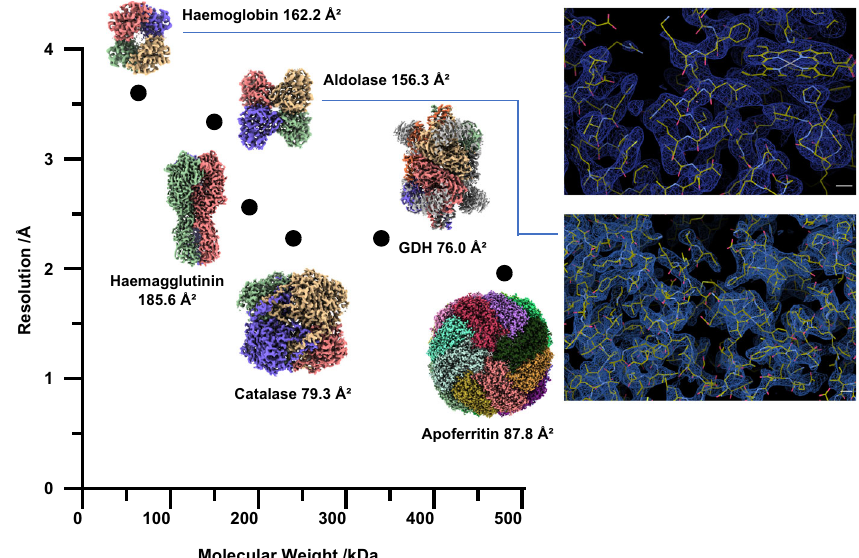
Fig. 6 A plot showing the relationship between the molecular weight and the fi nal resolution achieved in this study using the HFBI fi lm. Cryo-EM maps of haemoglobin (3.60 Å, 64 kDa), aldolase (3.28 Å, 150 kDa), in fl uenza haemagglutinin trimer (2.56 Å, 190 kDa), catalase (2.29 Å, 240 kDa), GDH (2.26 Å, 334 kDa) and apoferritin (1.96 Å, 480 kDa) are shown with their Rosentha – Henderson B -factors. The representative regions of cryo-EM maps of haemoglobin and aldolase are magni fi ed and shown on the right with their fi tted atomic models. Scale bar, 2